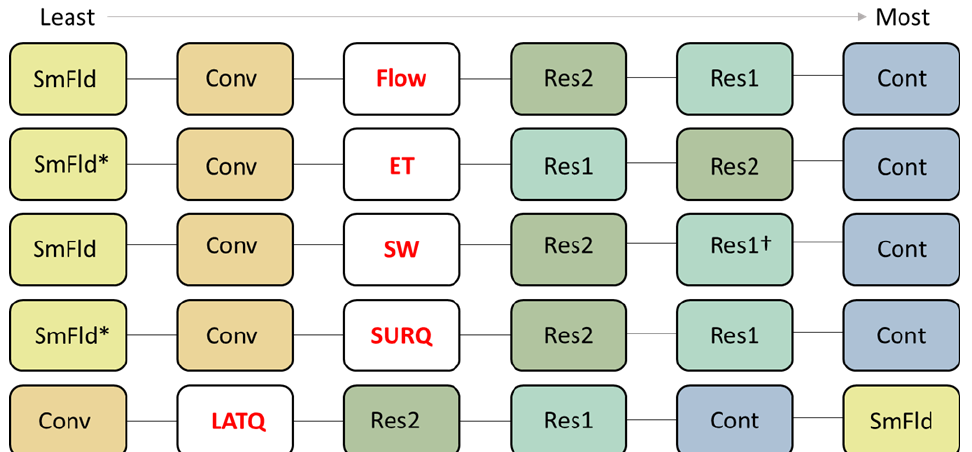
Figure 5. A ranking of each scenario (in the Nučice basin) according to its reinforcement of specific small water cycle parameters. All values are significantly different from the calibrated scenario (parameters in red, bold) unless indicated by *. † indicates a significant difference between Res1 and Res2.